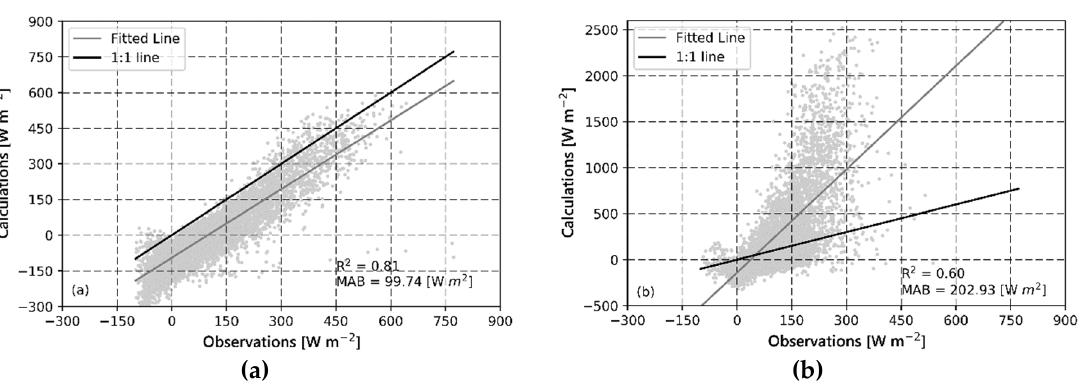
Figure 2. Turbulent fluxes estimated by the bulk method compared to observations: ( a ) Sensible Heat Flux (H) and ( b ) Latent Heat Flux (LE). The correlation for both H and LE was significant ( p -value < 0.01).